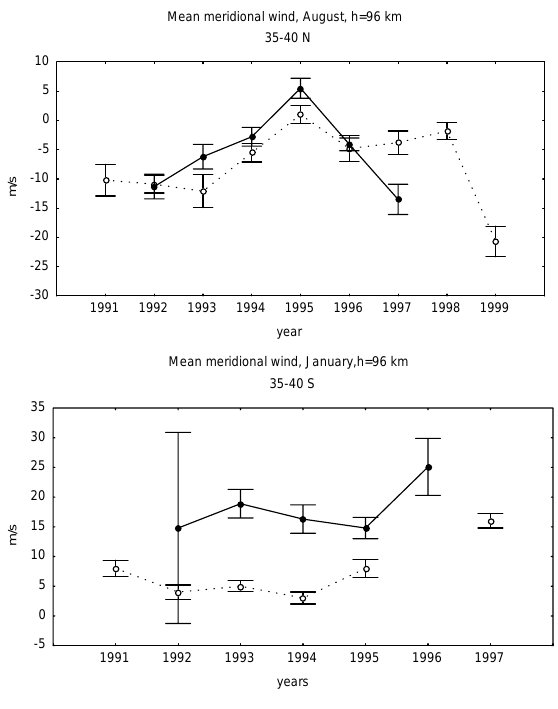
Fig. 12. Year-to-year variability of the monthly mean zonal wind at 96km during 1991–1999 as seen by HRDI and ground-based instruments. Filled circles: HRDI data for 35 ◦ –40 ◦ N for August (top) and 35 ◦ –40 ◦ S for January (bottom). Open circles: the cor- responding data at Shigaraki (35 ◦ N, 136 ◦ E) and Adelaide (35 ◦ S, 138 ◦ E). Vertical bars represent one standard deviation.